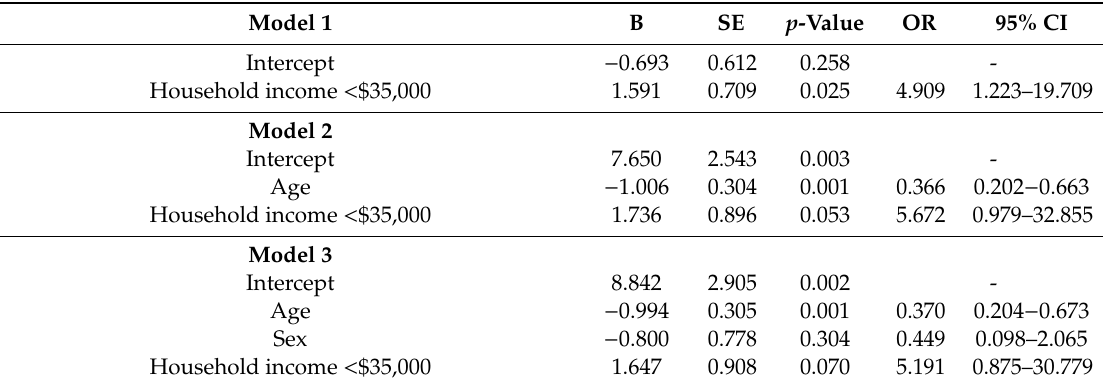
Table A1. Multinomial logistic regression results examining the association between food security indicators and meeting the MDD in infants 6–12 Months ( n =